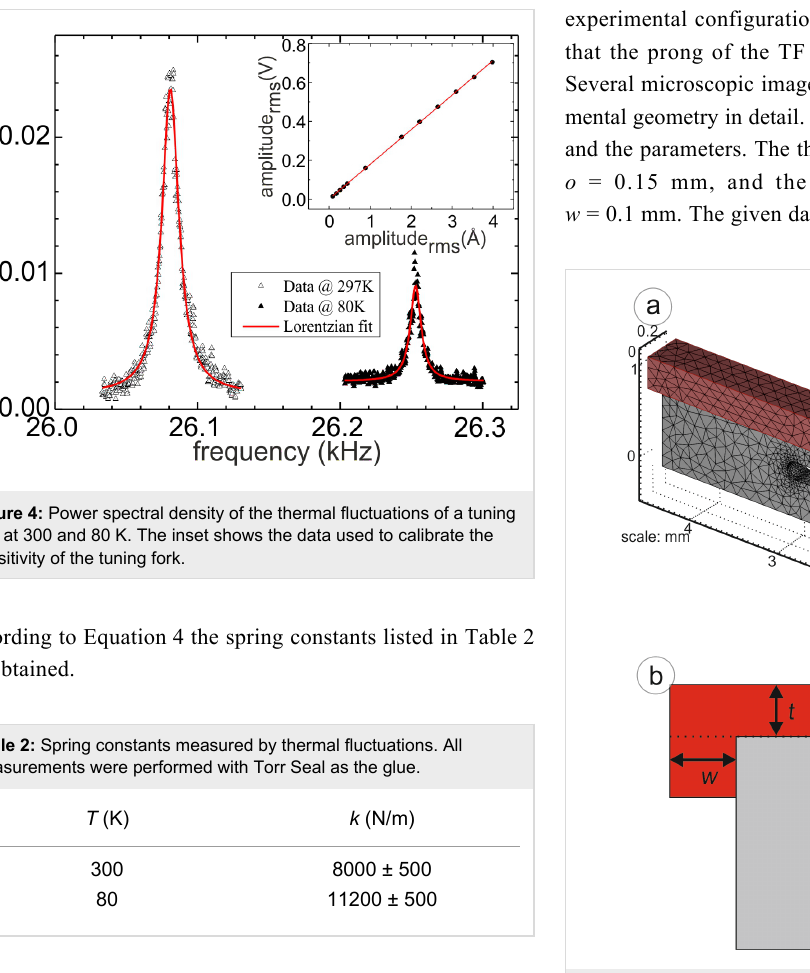
Figure 5: (a) Mesh-grid model of the tuning fork used for FEM simula- tions. (b) Sketch of the glue enclosing the tuning